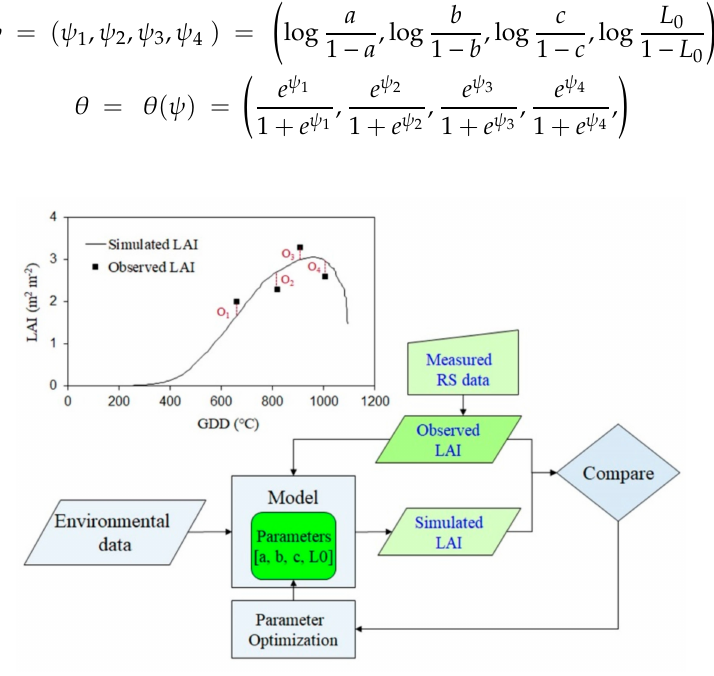
Figure 1. Diagrammatic representation of the remote sensing-integrated crop model (RSCM) for barley; model parameterization is based on remote sensing (RS) information and simulated versus observed leaf area index (LAI) according to the optimization process (top sub-panel). Table 1. Equations applied in the remote sensing-integrated crop model (RSCM) for